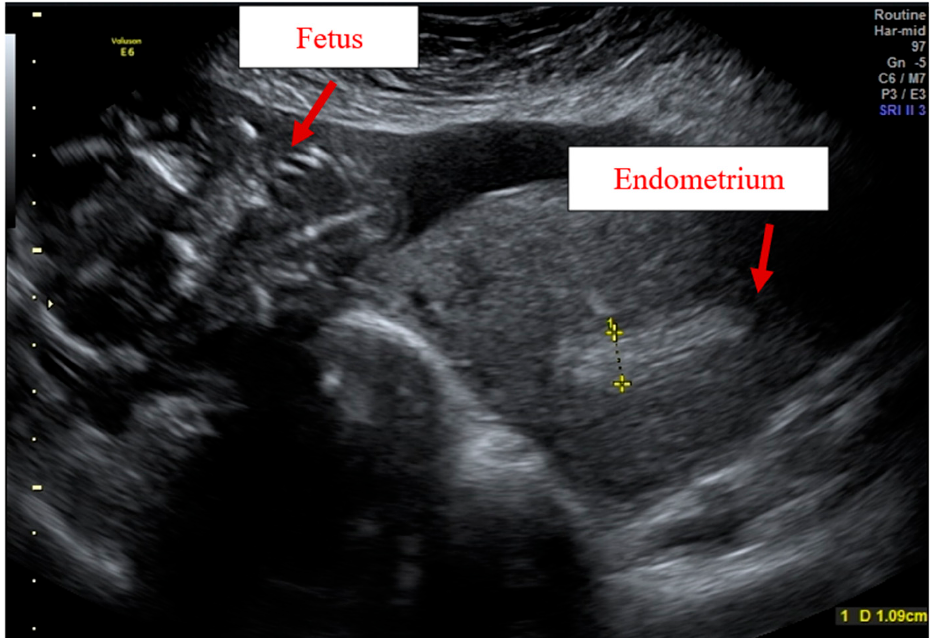
Figure 1. Ultrasound before laparotomy: fetus with amniotic sac completely expelled into the abdo- men.